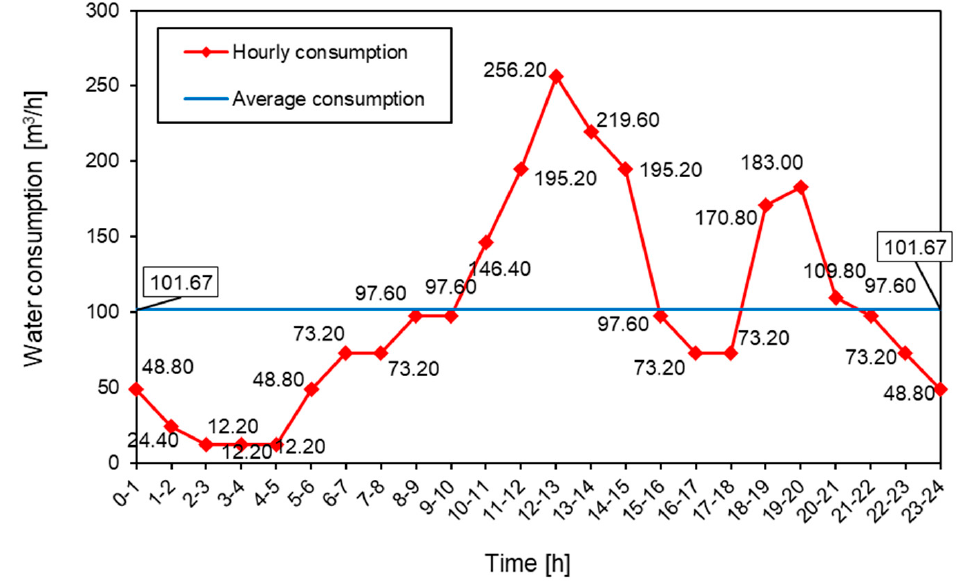
3 /day—Variant II